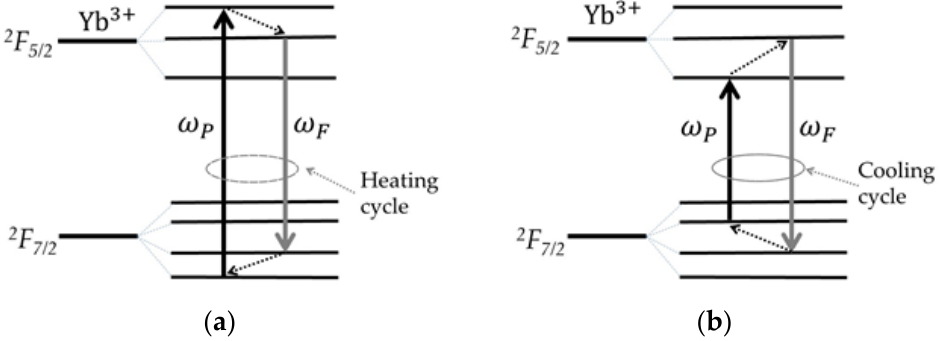
Figure 1. Energy levels of Yb 3+ ions doped in a solid. Arrows illustrate the excitation and decay processes for ( a ) Stokes and ( b ) anti-Stokes cycles.